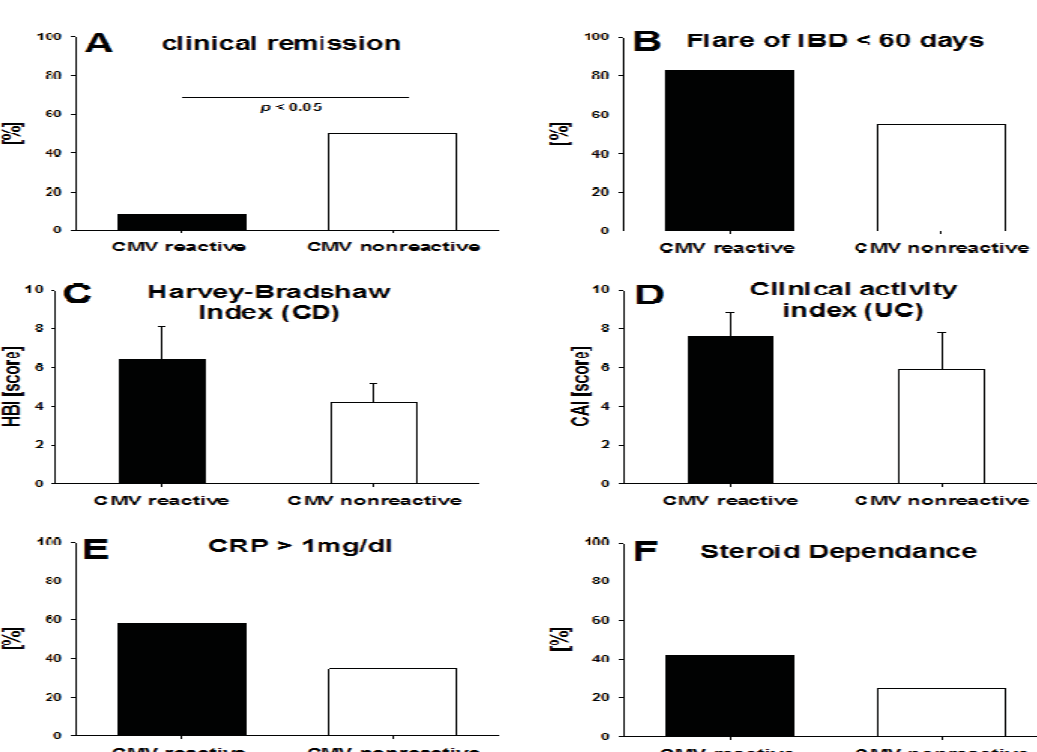
Figure 3. Detection of CMV reactive T effector cells in relation to disease activity. Each panel specifies a clinical criterion for ulcerative colitis (UC) and/or Crohn`s disease (CD). The percentages of GzB/PFN responsive vs . non responsive subjects with IBD (represented by the solid and open bars, respectively) are shown for each criterion. Also, disease activity indices are depicted for patients with CD and UC. Reactive IBD subjects were defined as individuals in whose PBMC the CMV peptide pool elicited spot counts of (cid:4)10 GzB-SFU ± SD, (cid:4)20 PFN-SFU ± SD (background subtracted) respectively. The Mann–Whitney rank sum test was used to evaluate statistical significance of differences in disease activity indices (panel C and D). For all other clinical criteria Fisher’s exact test was